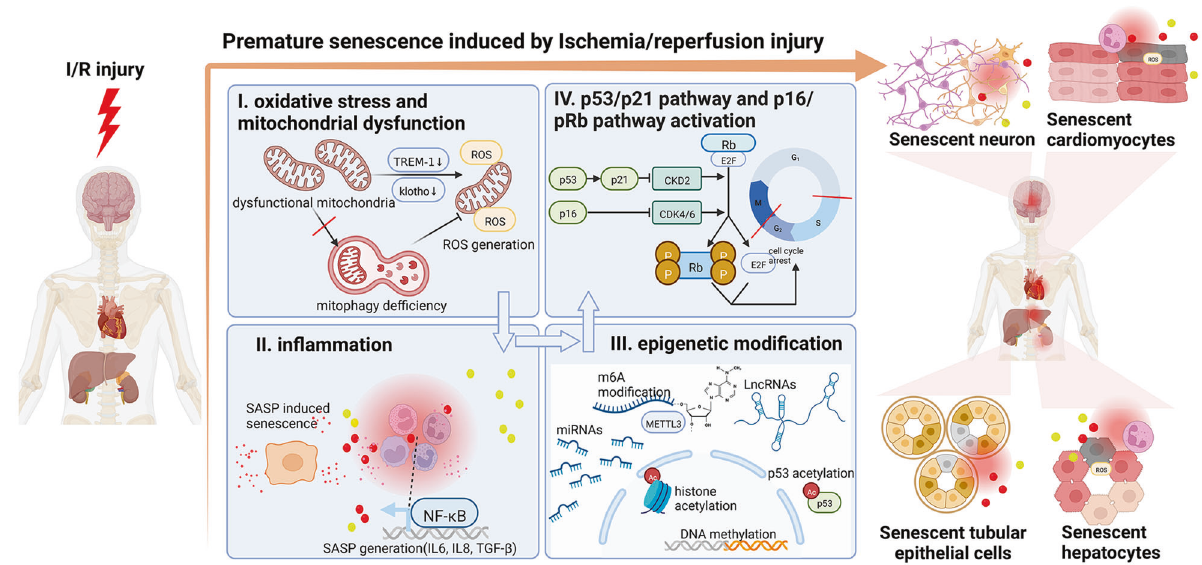
Fig. 3 Premature senescence induced by ischemia/reperfusion injury. IR injury fi rst initiates (I) oxidative stress and mitochondrial dysfunction, followed by (II) in fl ammation and (III) epigenetic modi fi cation, fi nally activates (IV) p53/p21 and p16 senescence pathway